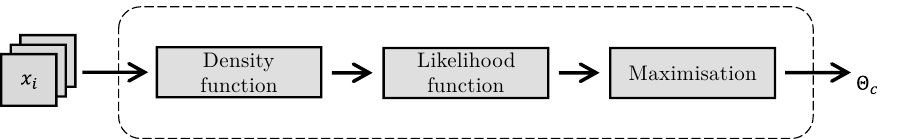
Figure 3. Maximum likelihood estimation based data quality fusion. Consisting of the steps probabil- ity density function, likelihood function and maximization.